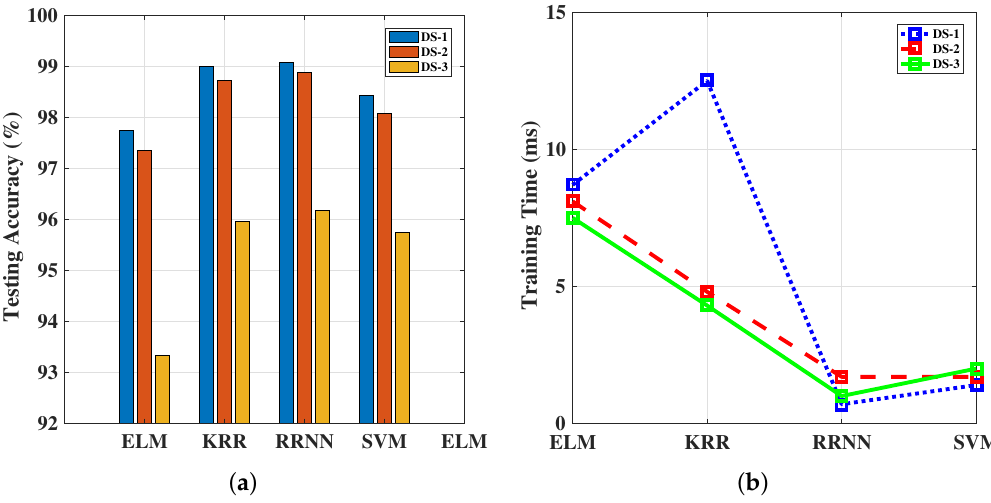
Figure 11. ( a ) Accuracy of the ELM, KRR, and RRNN algorithms across different datasets; ( b ) Training time for the ELM, KRR, and RRNN algorithms across different datasets. DS,